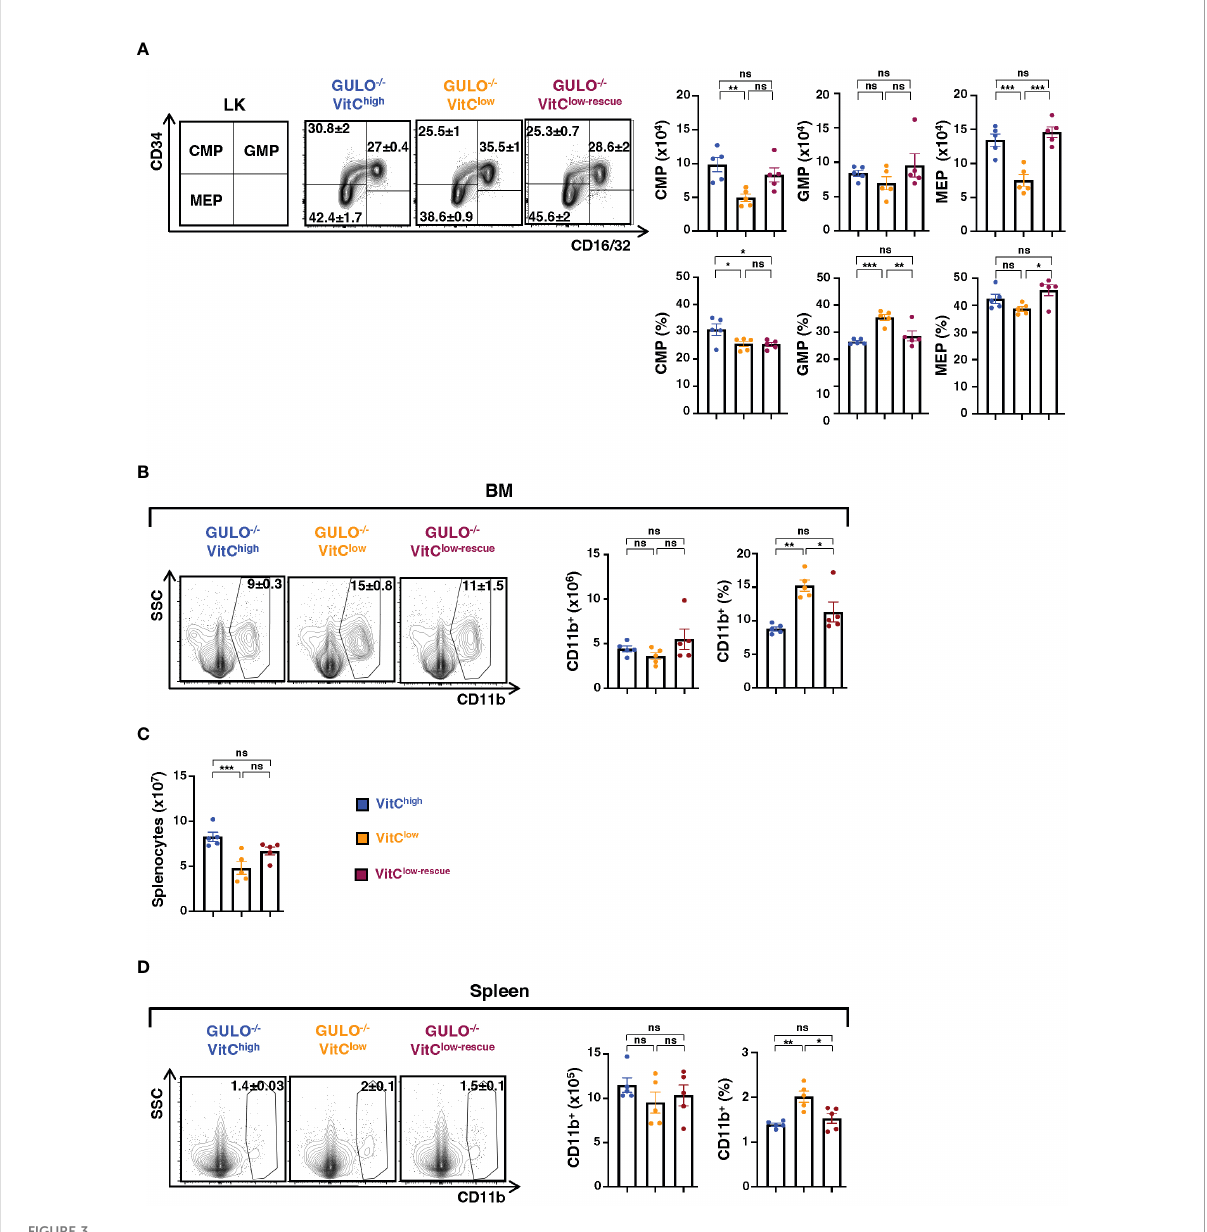
FIGURE 3 Differential impact of ascorbate deprivation on myeloid progenitor subsets. ( A Gating strategy used to de fi ne CMP (CD34 + CD16/32 - LK), GMP (CD34 + CD16/32 + LK), and MEP (CD34 - CD16/32 - LK) subsets are shown together with representative contour plots. Quanti fi cations and percentages of each subset ± SEM in 28 day old GULO -/- mice maintained under VitC-high, VitC-low, and rescue conditions are presented (n=5 mice per group). (B) CD11b + myeloid cells were evaluated in BM of the indicated groups by fl ow cytometry and representative contour plots are shown (left). Total numbers as well as percentages of CD11b+ cells are presented as means ± SEM (n=5 mice per group). (C) Splenic cellularity ± SEM in each condition is shown (n=5 mice per group). (D) CD11b + myeloid cells in spleen were evaluated as in panel (B) . Means ± SEM are shown (n=5 mice per group). Statistical differences were analyzed using a one-way ANOVA (Tukey ’ s test). *p < 0.05; **p < 0.01; ***p < 0.001; ns, not signi fi